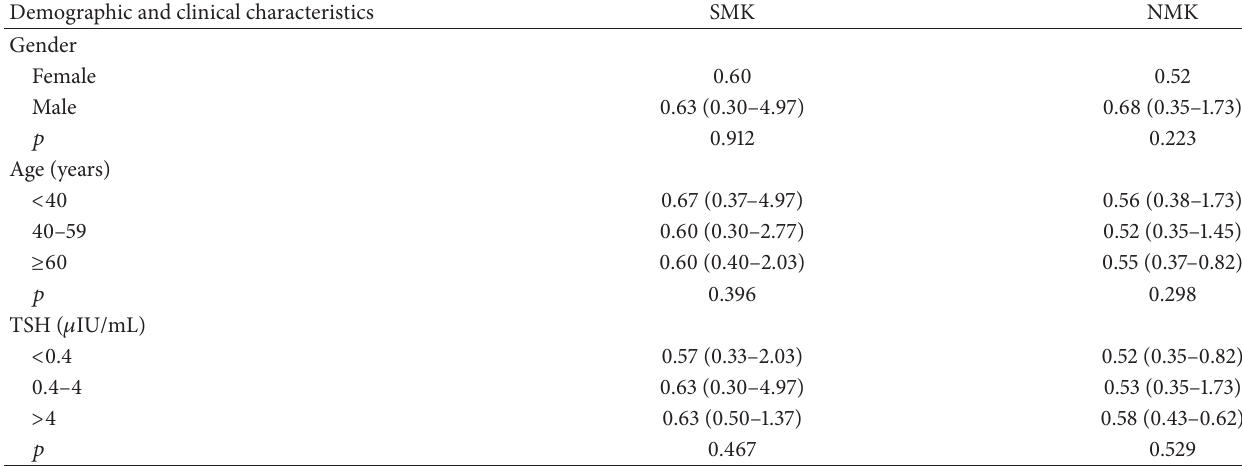
Table 1: Demographic and clinical characteristics in relation to serum midkine (SMK) and nodular midkine (NMK) concentrations. Demographic and clinical characteristics